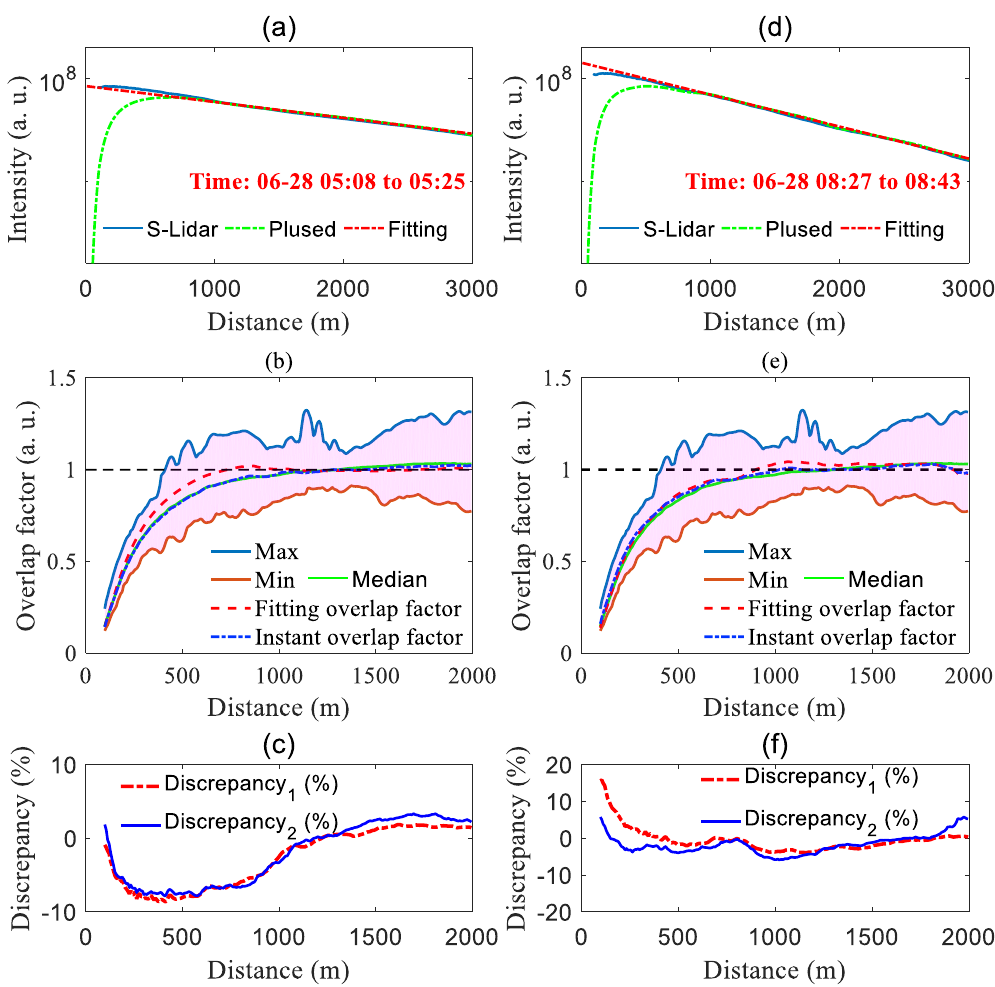
Figure 8. ( a ) and ( d ): lidar curves measured by the SLidar system and the pulsed lidar system under a homogeneous atmospheric condition, as well as the linear fitting curve (dashed curve). ( b ) and ( e ): overlap factors obtained with different approaches. The statistical maximum, minimum and median curves were evaluated with the system factor calibrated in the region of 1050–1500 m, based on all lidar curves. ( c ) and ( f ): the discrepancy between the instant overlap factor and the fitting overlap factor (Discrepancy 1 ) as well as the discrepancy between the median overlap factor and the fitting overlap factor (Discrepancy 2 ).